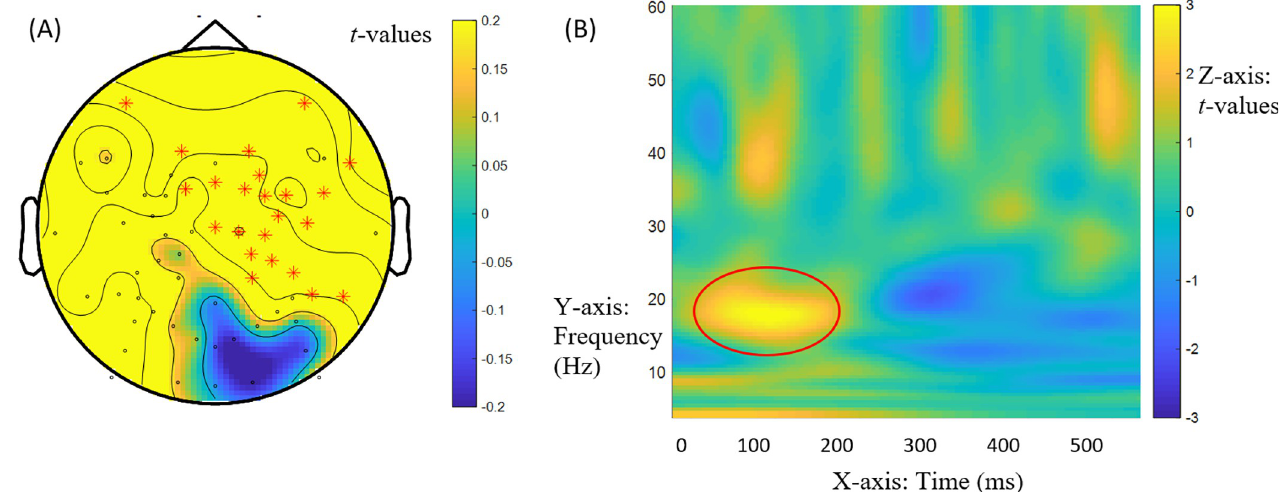
Fig 5. Interaction effect at verb dit ‘said’ at 18-19Hz (beta band). (A) Interaction of Mod-Comp contrasts in anaphora ([(2a)—(2b)]—[(2c)—(2d)]) with group in induced power at bridge verb dit ‘said’ at 18-19Hz (beta band) between 34ms and 194ms. The red marks indicate the electrodes for these interactions (electrodes ‘E2’, ‘E3’, ‘E4’, ‘E5’, ‘E6’, ‘E9’, ‘E10’, ‘E41’, ‘E48’, ‘E49’, ‘E50’, ‘E51’, ‘E52’, ‘E53’, ‘E54’, ‘E56’, ‘E57’, ‘E58’, ‘E59’, ‘E60’, ‘E61’, ‘E62’, ‘E63’). (B) Time (x axis) frequency (y axis) plot of interaction effect in induced power (z axis). The circled area shows the effect.